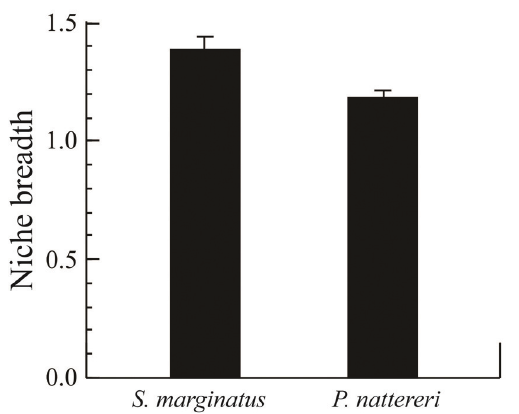
Figure 5. Analysis of covariance utilizing the total weight Figure 4. Values of niche breadth (mean±standard error) of stomachs as covariable for individuals of Pygocentrus nattereri and Serrasalmus marginatus caught in the Negro for Pygocentrus nattereri and Serrasalmus marginatus caught in the Negro River, Nhecolândia region, Pantanal, River, Nhecolândia region, Pantanal, from October 2005 from October 2005 through August 2008. through August 2008. Bars indicate standard Table 3. Result of the Analysis of Covariance for the stomach weight for S. marginatus and P. nattereri in the Negro River Floodplain, Nhecolândia region, Pantanal from 2005 to 2008. ANCOVA N